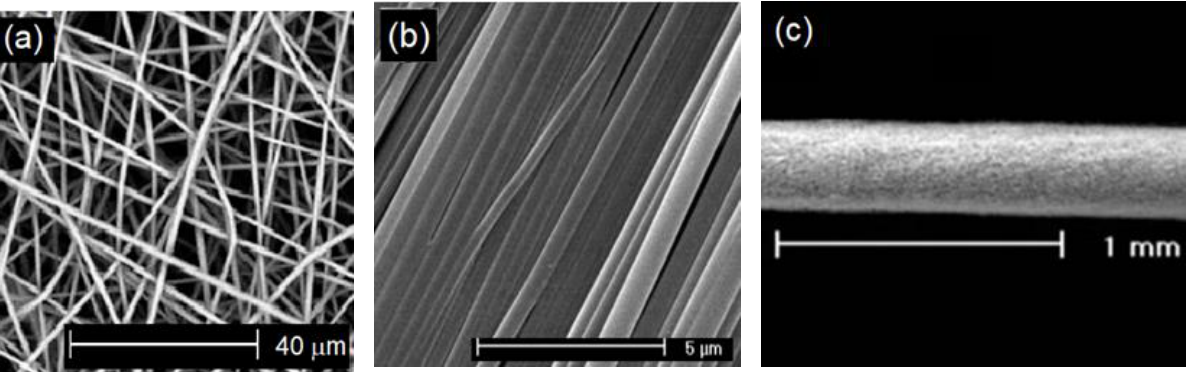
Figure 7. Different arrangements of fiber deposits produced via electrospinning of PLA: ( a ) random. Reproduced with permission from [40] (License number: 5235950005044), ( b ) oriented, re-